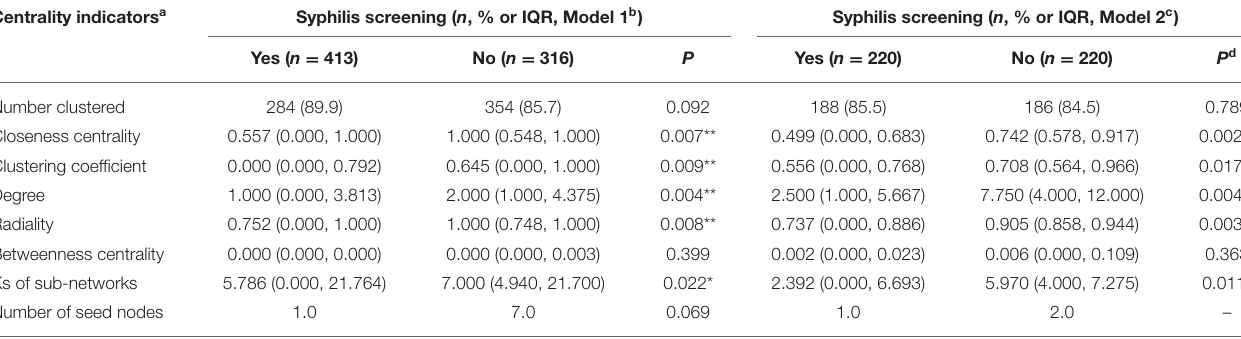
TABLE 2 | Centrality analysis of HIV-1 transmission networks for MSM with or without syphilis testing during 2008-2012 in Guangzhou, China. Centrality indicators a Syphilis screening ( n , % or IQR, Model 1 b ) Syphilis screening ( n , % or IQR, Model 2 c ) Yes ( n = 413) No ( n = 316) P Yes ( n = 220) No ( n = 220) P d Number clustered 284 (89.9)